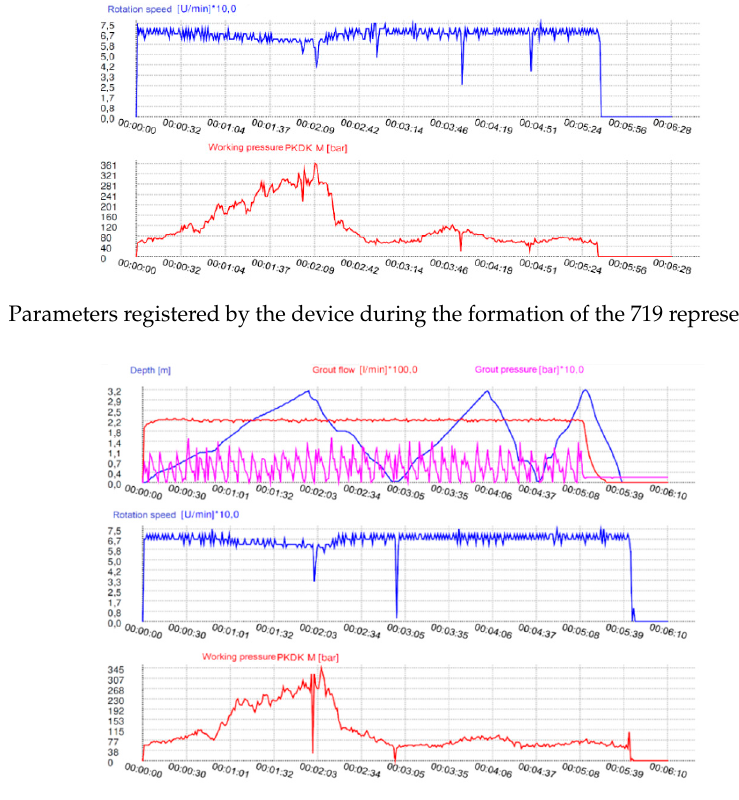
Figure 13. Parameters registered by the device during the formation of the 709 representative